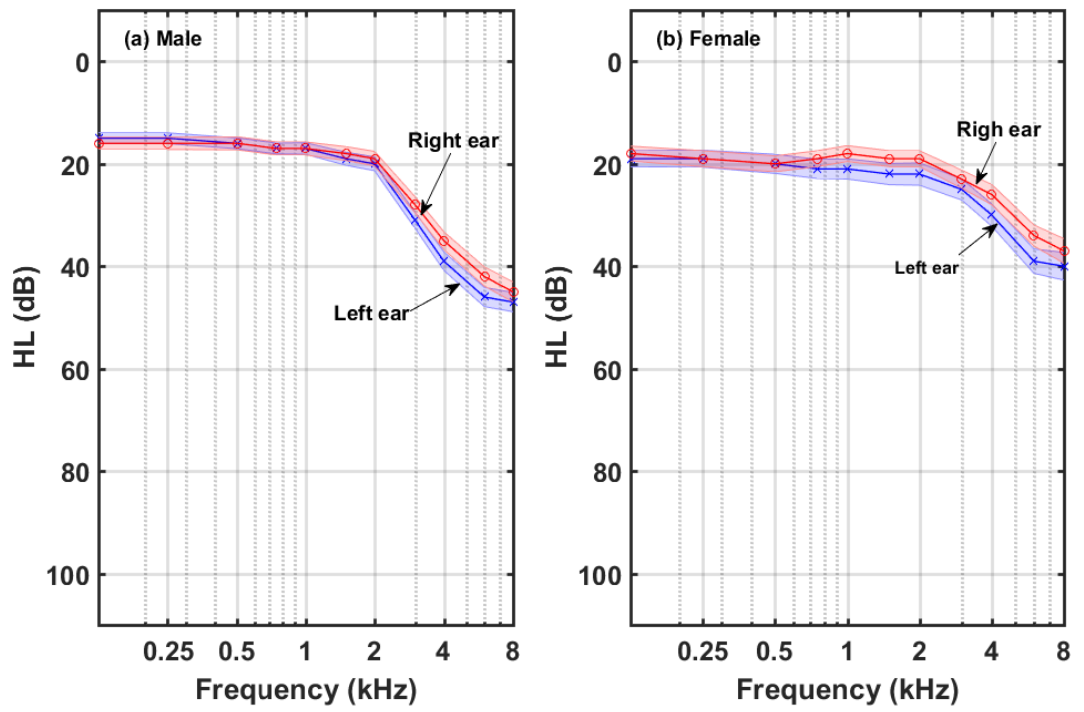
Figure 2. Mean hearing levels of the ( a ) 178 male and ( b ) 92 female participants in left and right ears. Shaded area around the HL curves outlines confidence intervals. Shaded area around the HL curves outlines confidence intervals.